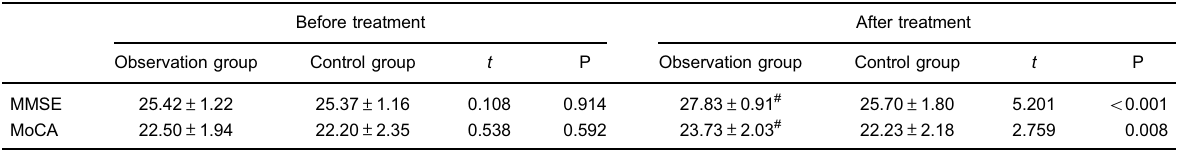
Table 4. Comparison of cognitive scores before and after treatment of patients with acute cerebral infarction treated with alteplase (observation group) or batroxobin (control group). Before treatment